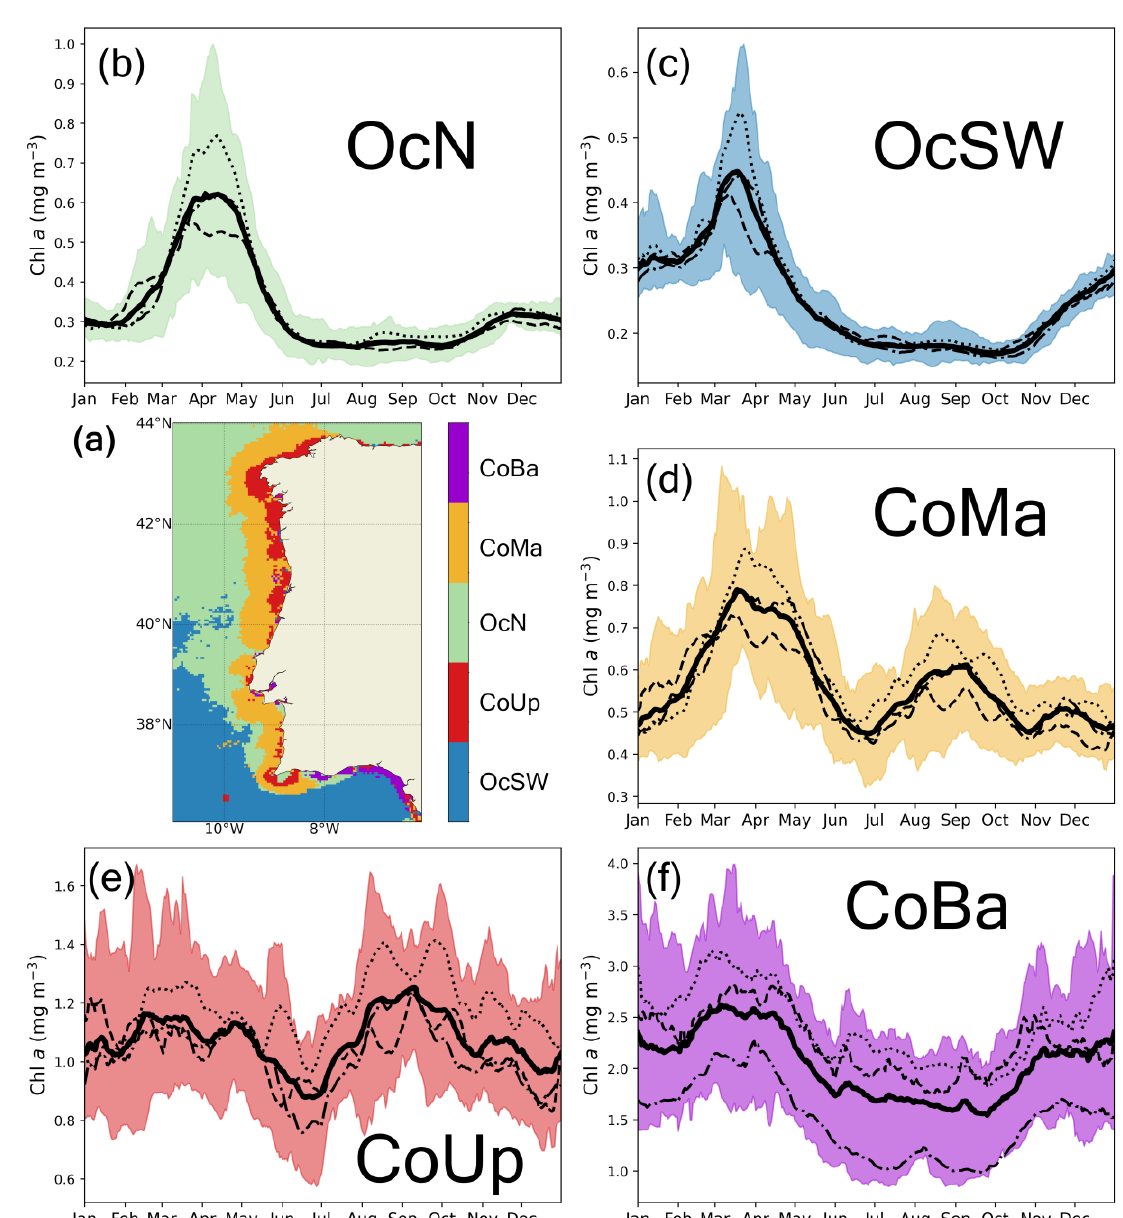
Figure 6. ( a ) Phenoregions identified from the clustering analysis (see the color code): OcN (Oceanic North; ( b )), OcSW (Oceanic Southwest; ( c) ), CoMa (Coastal Continental Margin; ( d )), CoUp (Coastal Upwelling; ( e )), and CoBa (Coastal River Basins; ( f) ). For each phenoregion, the chl- a (mg m − 3 ) annual cycle between 1998 and 2019 is plotted (black solid line), along with the 1998 – 2004 (dashed), 2005 – 2011 (dotted), and 2012 – 2018 (dash-dotted) mean cycles.